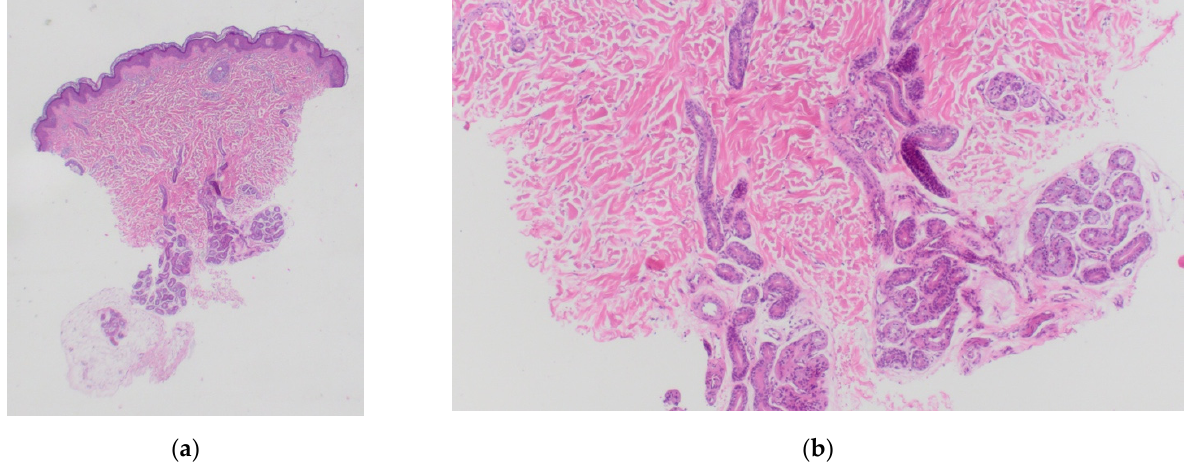
Figure 2. Punch biopsy sample, hematoxylin-eosin staining. ( a ): 10× magnification. ( b ): 40× magnification. The patient was treated with multiple intradermal injections of botulinum toxin type A on the affected area, with a satisfactory response, remaining with anhidrosis seven months after follow-up.